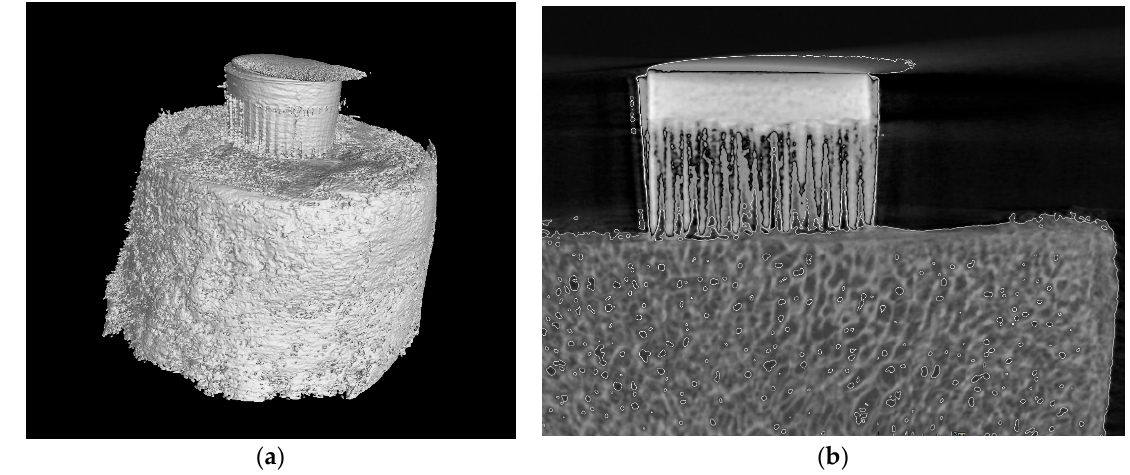
Figure 6. ( a ) The three-dimensional (3D) view of the bone-implant specimen; ( b ) The representative two-dimensional (2D) slice of the micro-CT reconstructed specimen before tests.